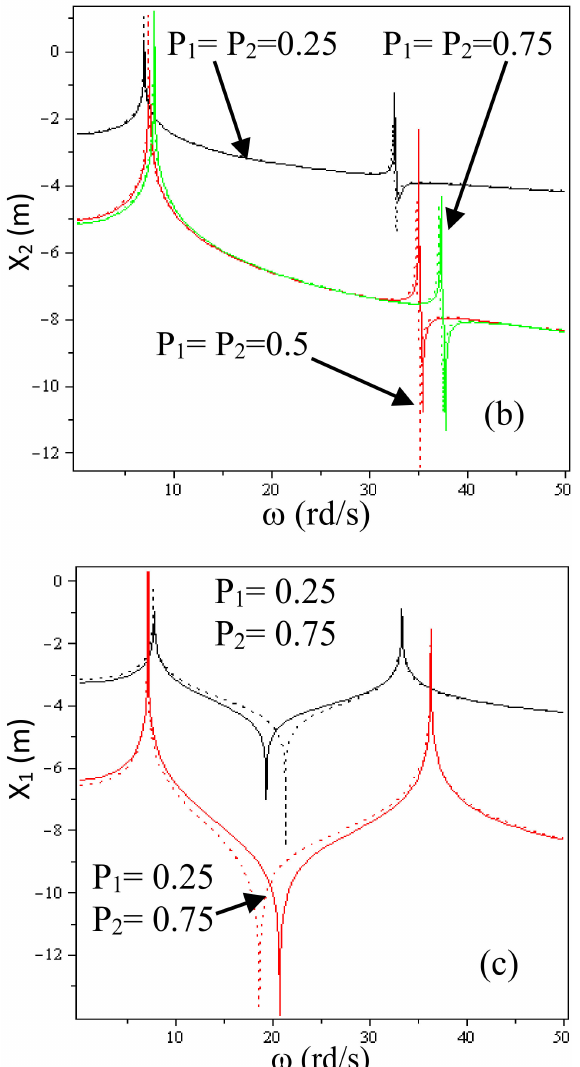
Figure 2. ( a ). Displacement x 1 versus the circular natural frequency ω : superposition of the solution by the RPM (____) and the exact solution (—–). ( b ). Displacement x 2 versus the circular natural frequency ω : superposition of the solution by RPM approach (____) and the exact solution (——). ( c ). Displacement x 1 versus the circular natural frequency ω : superposition of the solution by the RPM approach (____) and the exact solution